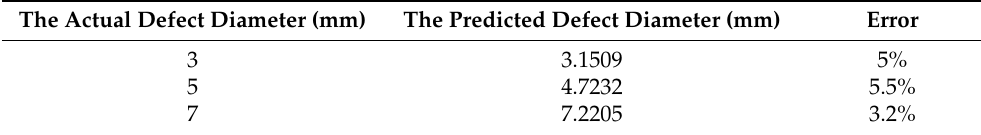
Table 3. The predicted diameter and actual diameter of defect in this work.